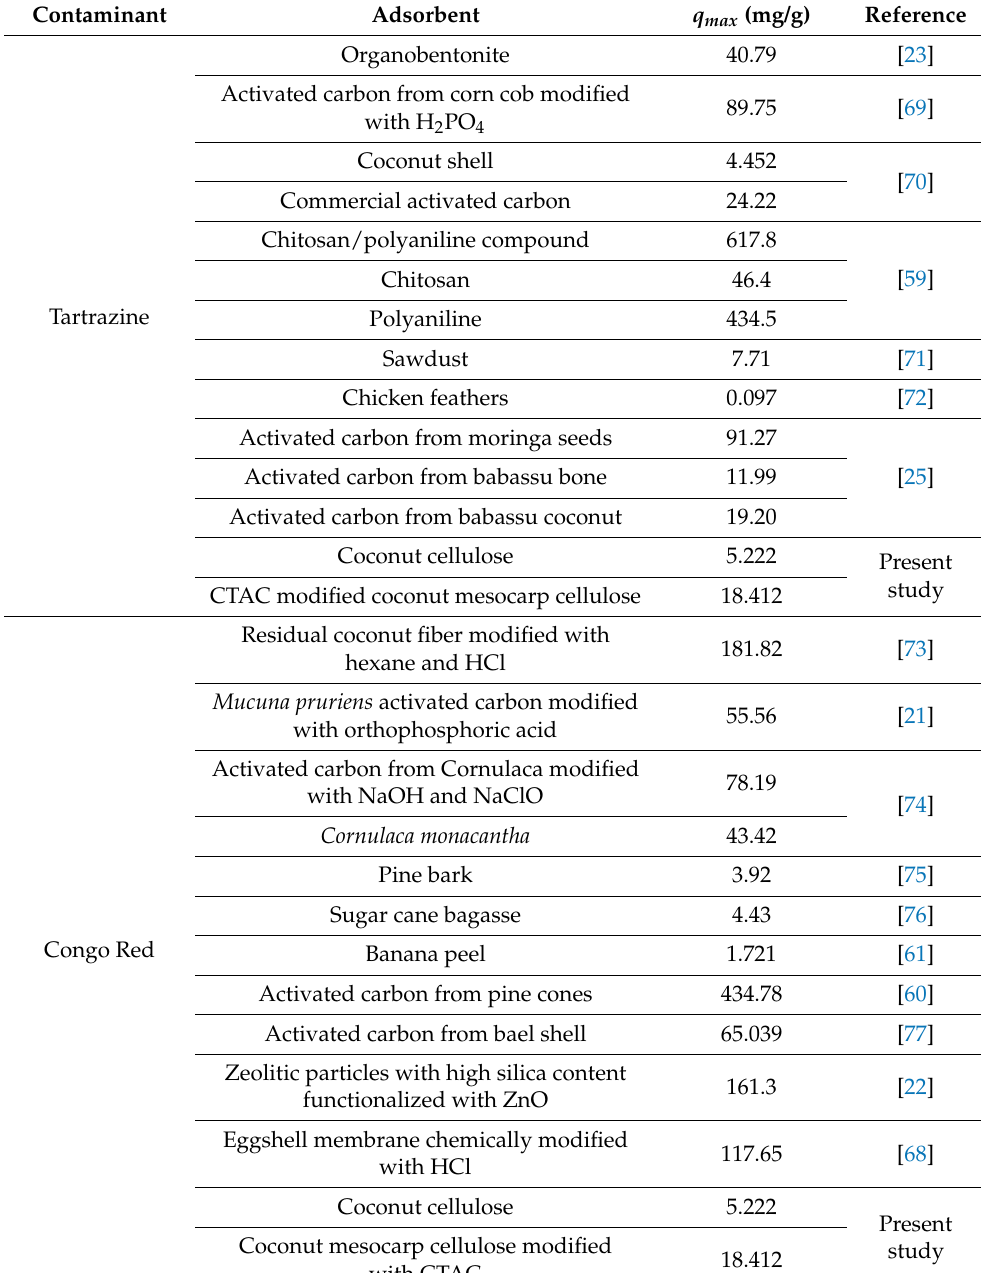
Table 5. q max of tartrazine and Congo Red according to the Langmuir model using various adsorbents. Contaminant Adsorbent q max (mg/g)